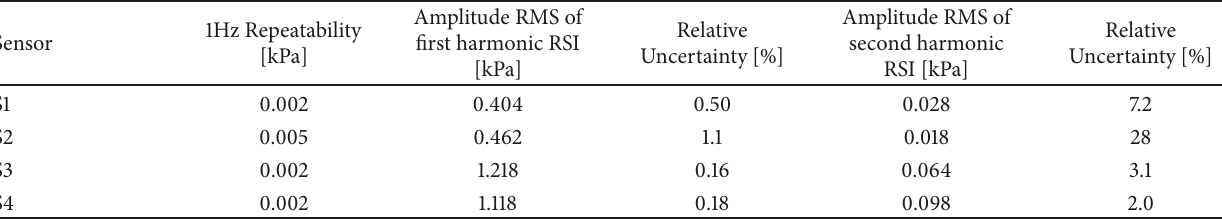
Table 2: Uncertainty budget for RSI first and second harmonic amplitudes, BEP F99.